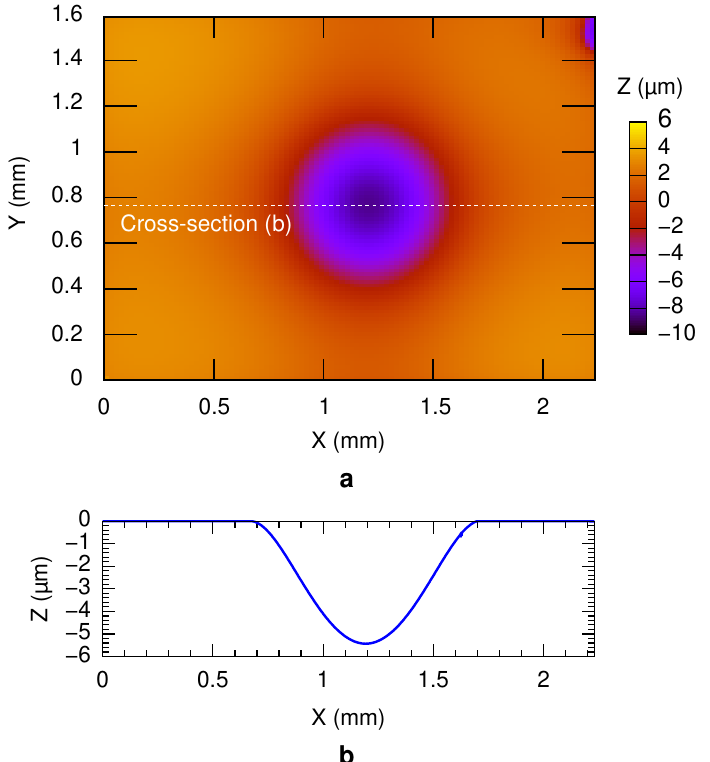
Figure 8. ( a ) Surface profile of the diaphragm after wafer bonding process. ( b ) Cross-sectional 2D surface profile from ( a ).